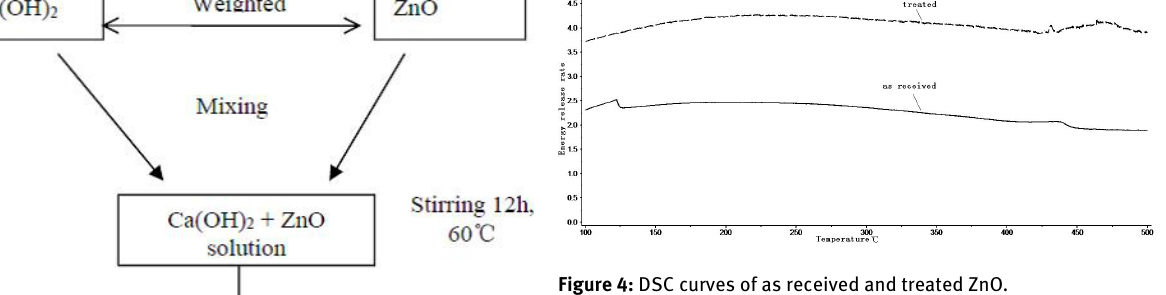
Figure 4: DSC curves of as received and treated ZnO.